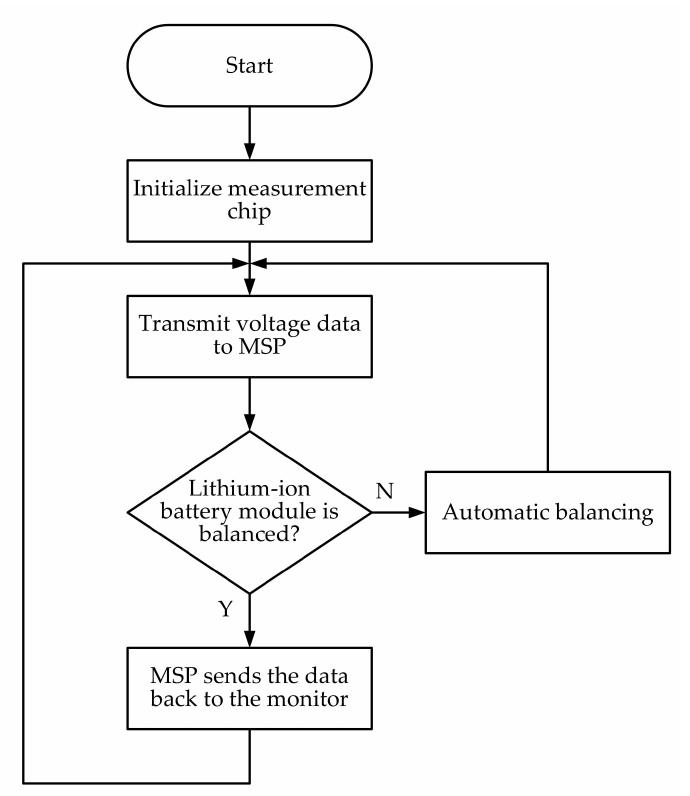
Figure 4. Flow chart of the battery